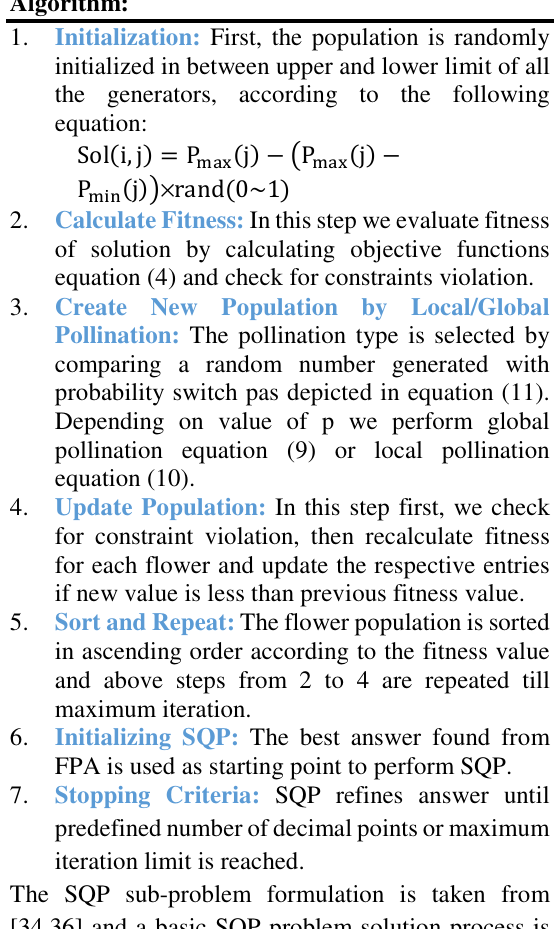
Fig. 1: Proposed Hybrid FPA-SQP Algorithm Flow